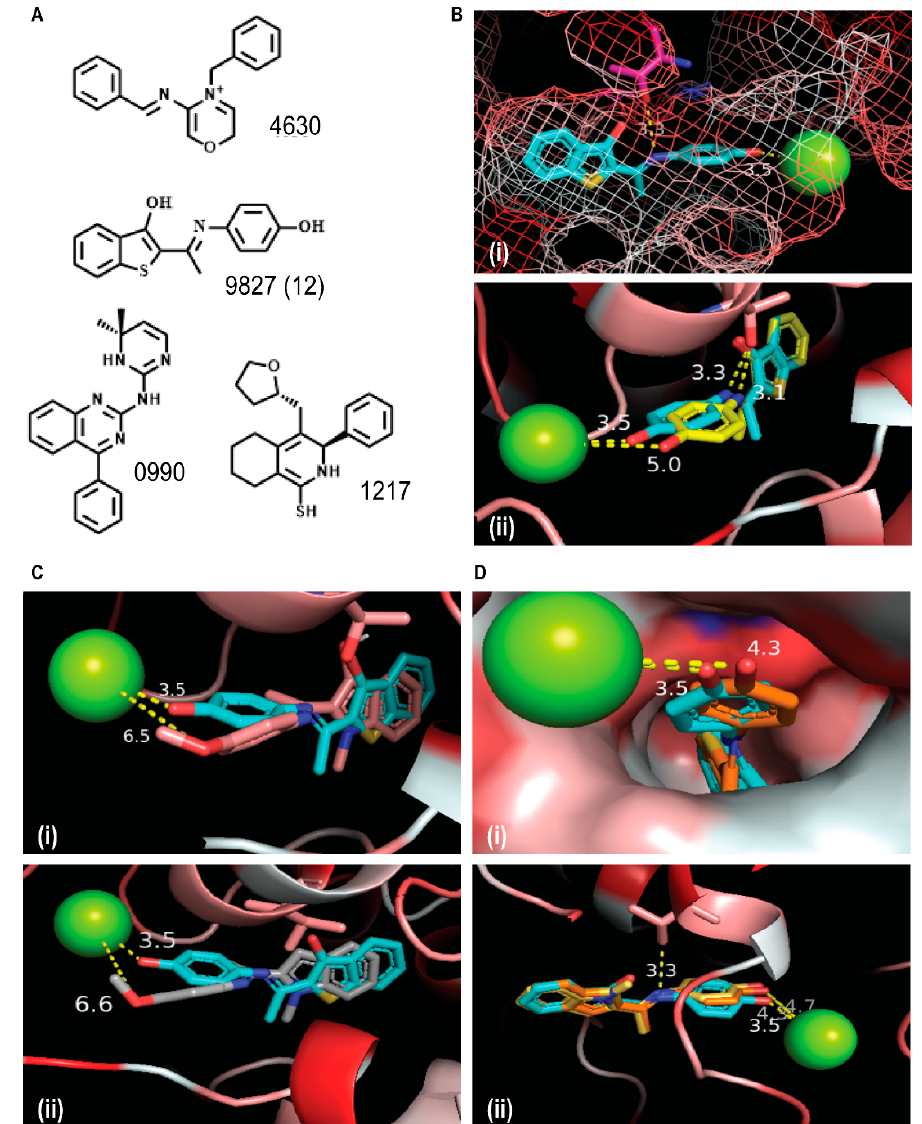
Figure 1. Structure-based design of G α i 2 Inhibitors. ( A ) Representative examples of G α i 1 Inhibitors. ( Bi ) Docked output of compound 9827 ( 12 ) at the active site of G α i 1–GDP, showing the placement of the thiophene-hydroxyl and benzothiophene sulfur groups. ( Bii ) Overlay of docked orientations of 12 in the presence (cyan) or absence (yellow) of Mg 2 + ion. ( C ) Overlay of docked orientations of 12 (cyan) and 9a (teal) ( Ci ), and 12 (cyan) and 9b (grey) ( Cii ). ( Di ) Overlay of the docked outputs of 12 (cyan) and 13 (orange). ( Dii ) Overlay of the docked outputs of 12 (cyan), 13 (orange) and 14 (brown).